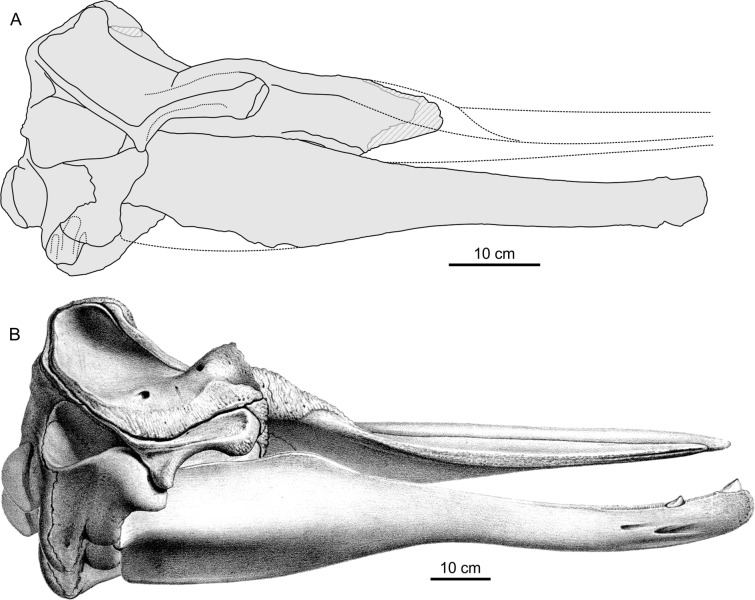
Comparison between Chavinziphius maxillocristatus and Beradius arnouxii skulls.Crania and articulated mandibles in right lateral view of C. maxillocristatus holotype (MUSM 2538) and Berardius arnouxii
Duvernoy, 1851 (modified from Van Beneden & Gervais, 1868–1879: pl. 23), scaled with the same neurocranium length. Stippled lines for the reconstructed anterior part of the rostrum of C. maxillocristatus.